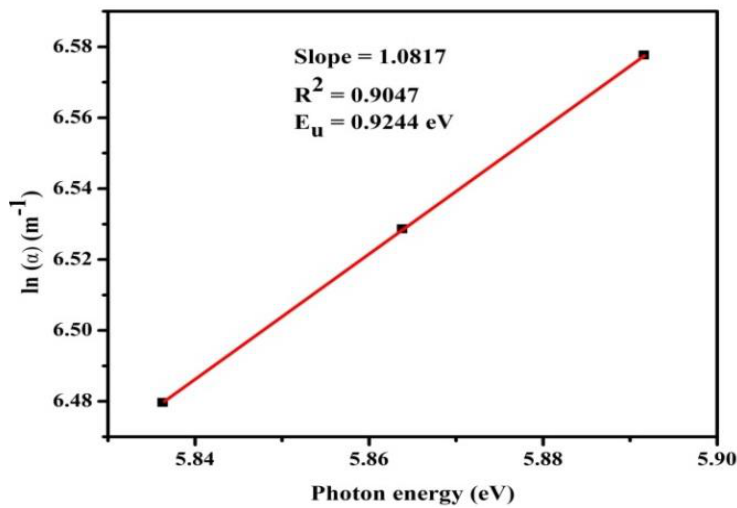
Figure 5. Plot ln(α) vs. hυ for LPPMA .